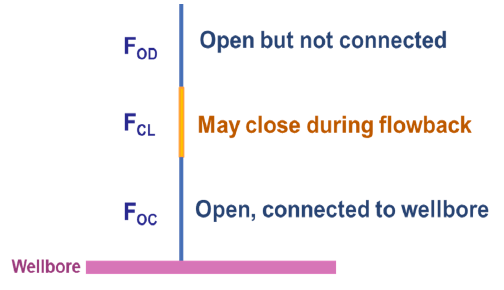
Figure 20. Complex fracture network simplified to an effective model.